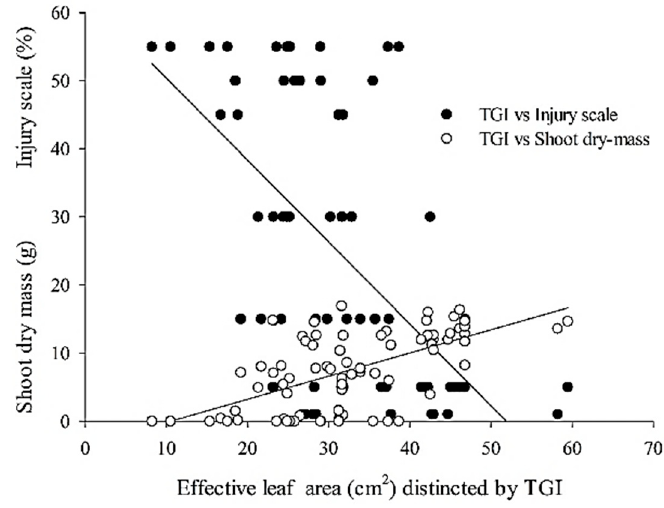
Figure 6. Scatterplot between triangular greenness index (TGI) and soybean injury scale at 45 days after sowing and soybean shoot dry mass at 99 days after sowing.